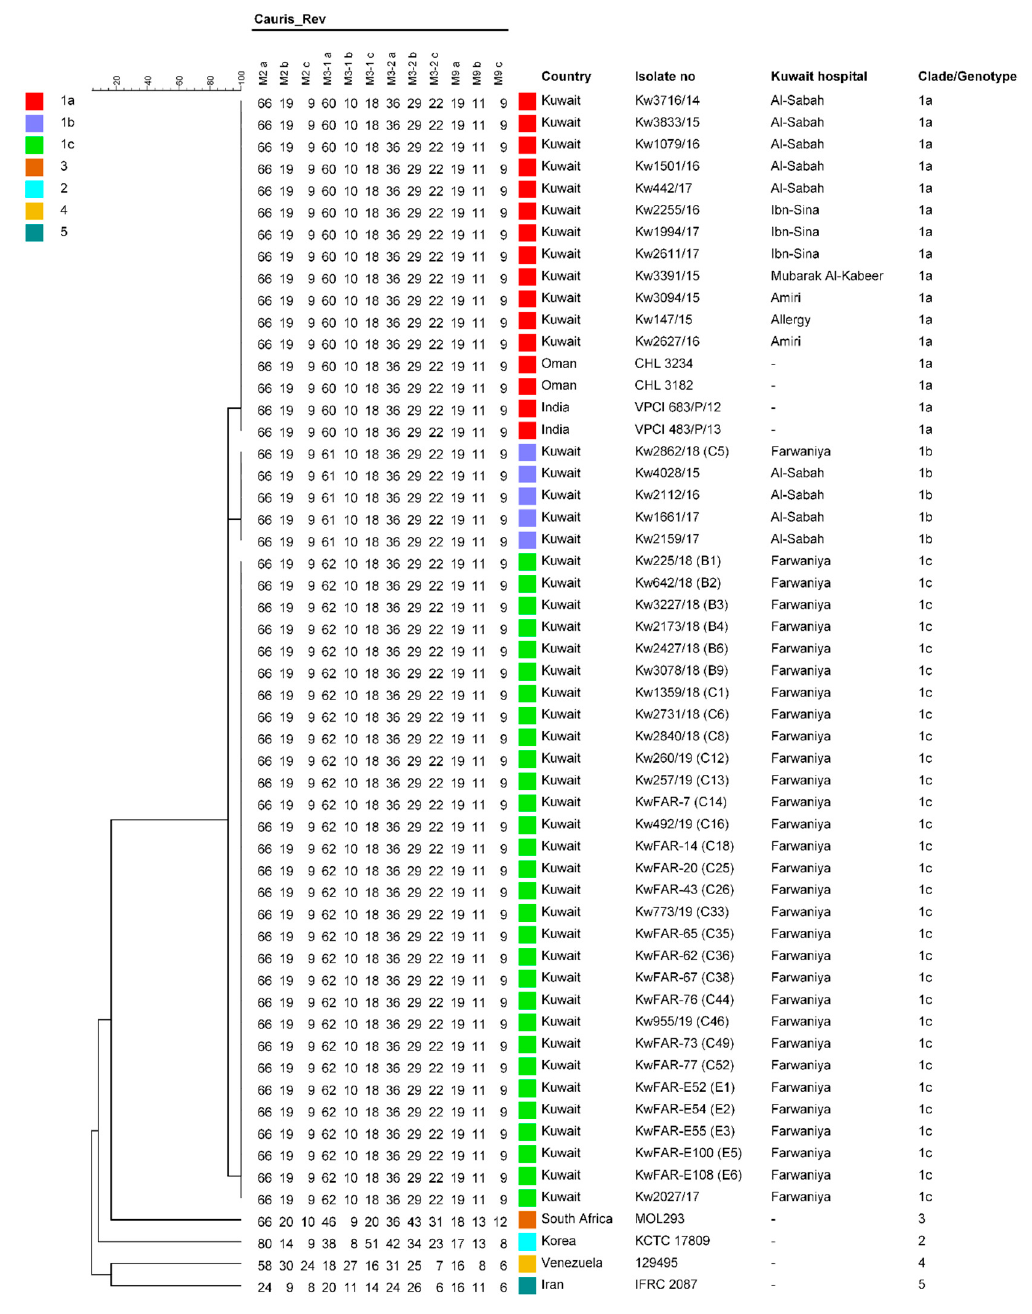
Figure 2. Short tandem repeat (STR) typing patterns of C. auris outbreak isolates from Farwaniya Hospital in Kuwait. Only one isolate from each patient is shown. Multiple isolates from each patient from same or different sites exhibited identical patterns. The first C. auris isolate (Kw2027/17) obtained from this hospital in 2017 as well as isolates from other hospitals in Kuwait are also included for comparison purpose. Representative South Asian clade 1 isolates from India and Oman and clade 2 to 5 isolates from Korea, South Africa, Venezuela and Iran, respectively, are also shown. The source of outbreak isolates and patient no. are also shown. (B1) = bloodstream isolate from candidemia patient 1; (C1) = colonizing strain from colonized patient 1; (E1) = environmental isolate 1. The scale in the upper left corner represents similarity (%).